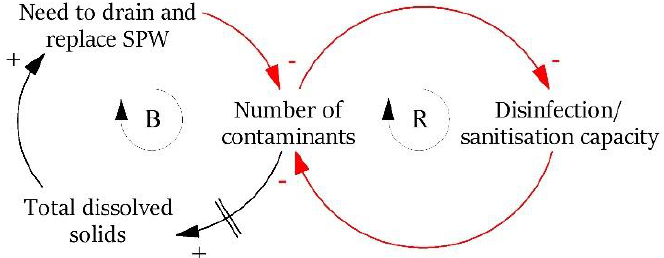
Figure 2. Example CLD with a negative (balancing, B) and a positive (reinforcing, R) feedback loop, and a delay.